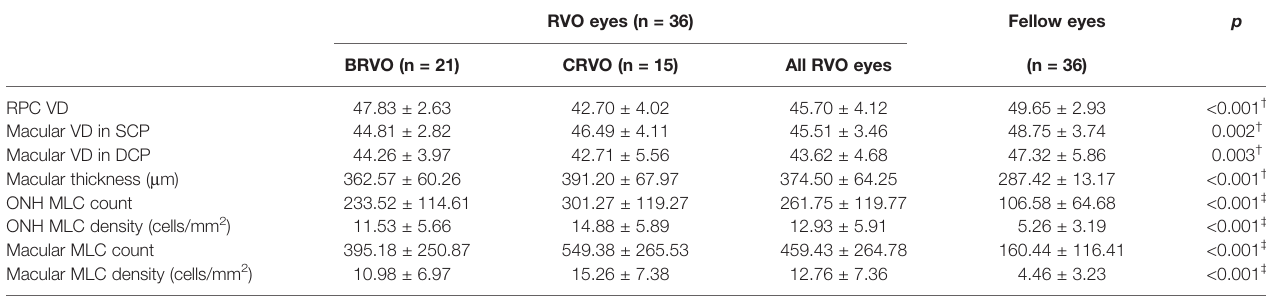
TABLE 1 | MLC parameters and retinal parameters in RVO eyes and the fellow